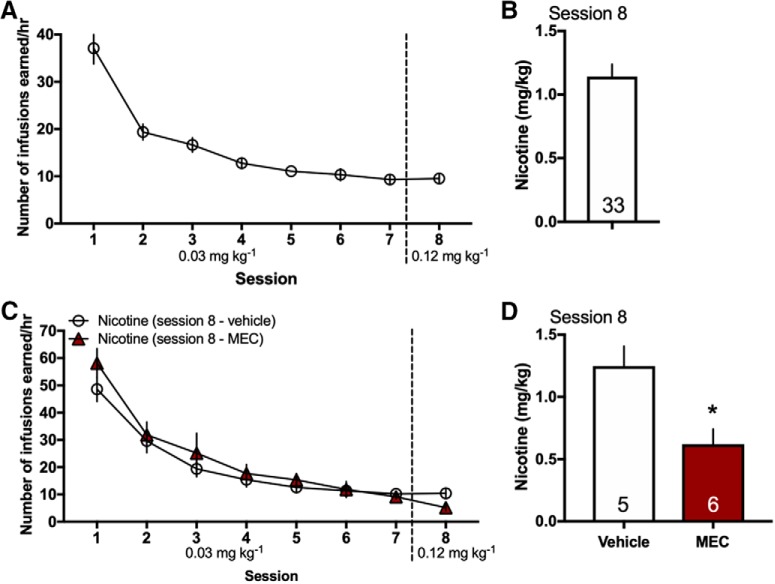
Intravenous nicotine self-administration in rats. Rats were trained in the intravenous nicotine self-administration protocol; access to the acquisition dose of 0.03 mg kg−1 per infusion was provided for 7 d, followed by 0.12 mg kg−1 per infusion on the eighth session. A, The number of nicotine infusions across sessions during nicotine self-administration corresponds to tissue analyzed for studies shown in Figures 4, 6, 7 (n = 33). B, On the final session, the subjects shown in Figure 5A self-administered a mean of 1.1 mg/kg nicotine (±0.09 SEM). C, For the data presented in Figure 6C, groups were tested across doses as described above but were administered either vehicle or mecamylamine before the self-administration session on session 8 (n = 5–6/group). D, For session 8, a significant decrease in the amount of nicotine consumed was found in the mecamylamine group compared to the vehicle group; *p < 0.05. The mean nicotine intake (mg/kg) ± SEM for each group was: Vehicle: 1.248 ± 0.16 and Mecamylamine: 0.62 ± 0.122. Specific subject numbers per group are denoted on the bar graphs. Data represent mean values ± SEM.